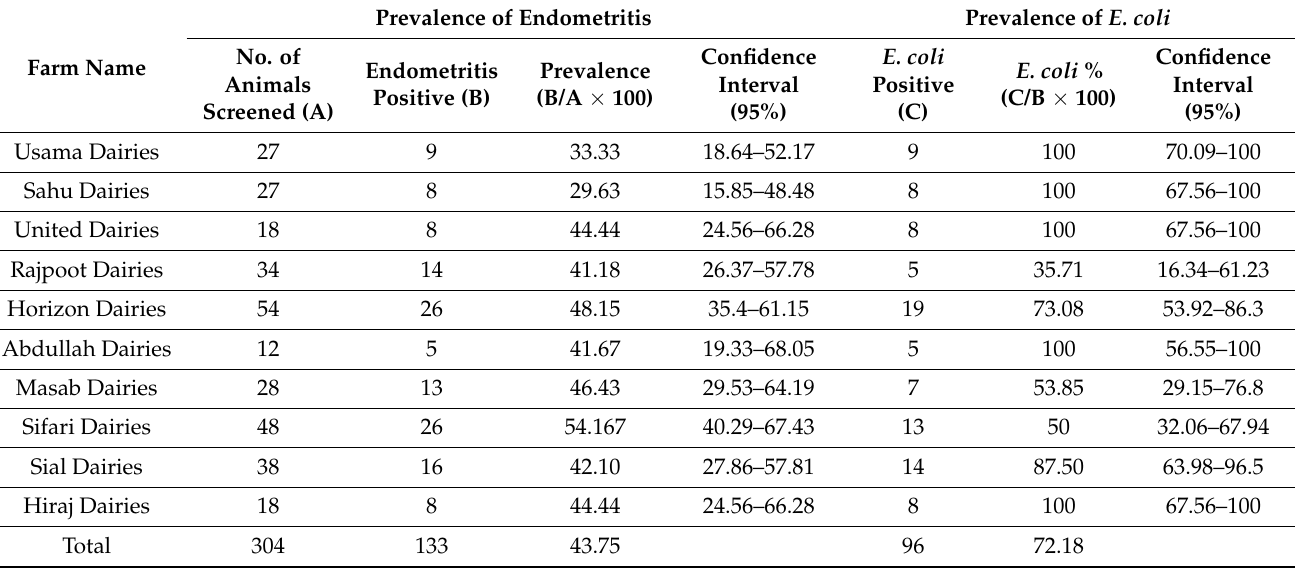
Table 1. Prevalence of endometritis and E. coli